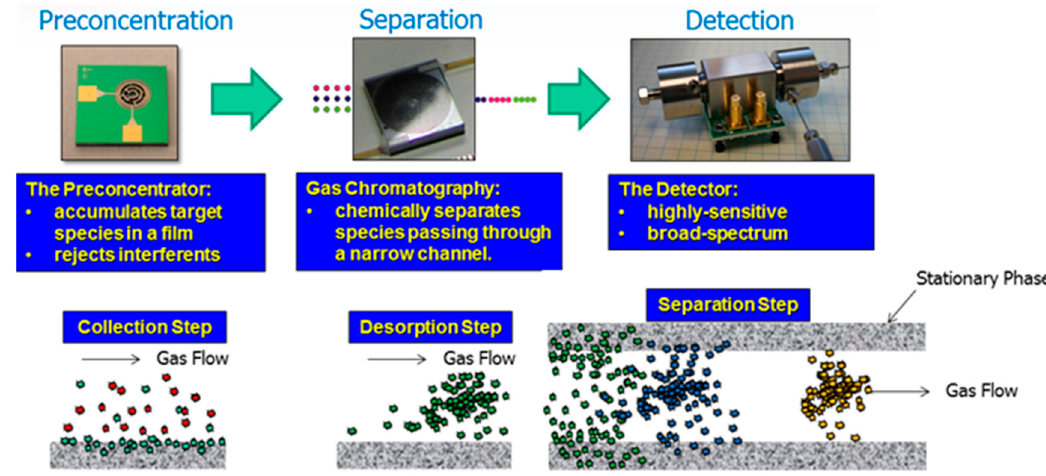
Figure 20. Schematic representation of the operating principles of a portable GC- μ System.